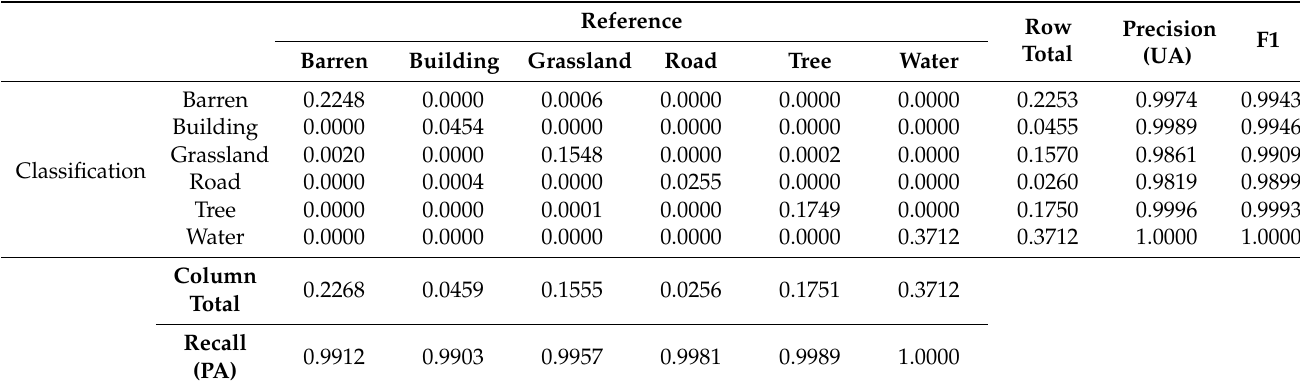
Table 4. Scene labelling accuracy assessment for DeepSat SAT-6 dataset, with values in the table representing proportions of outcomes based on class prevalence in the benchmark dataset. OA = 0.9967.